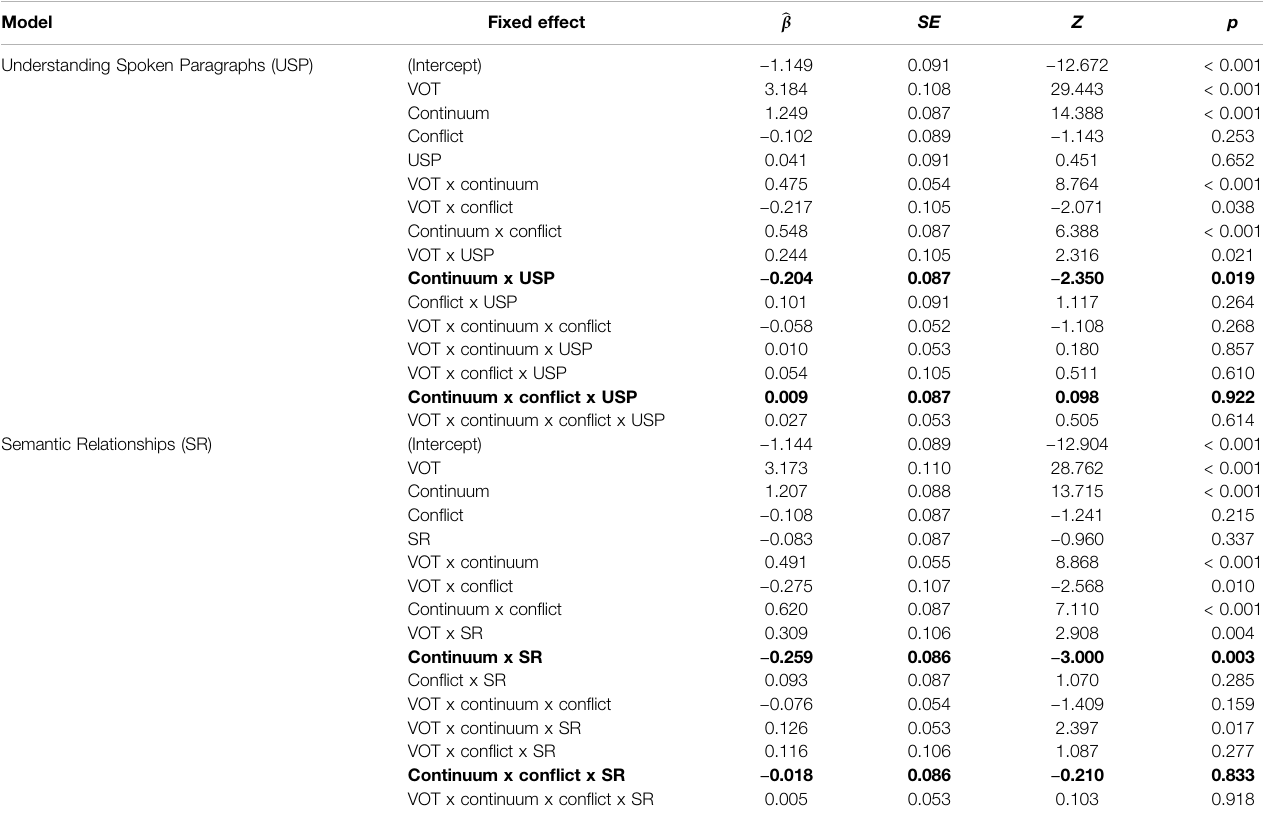
TABLE 3 | Results of the mixed effects models for /k/ responses that included fi xed effects of VOT, continuum, con fl ict, and CELF-5 receptive language subtest (each in a separate model). Bold font is used to mark the key interactions of interest.